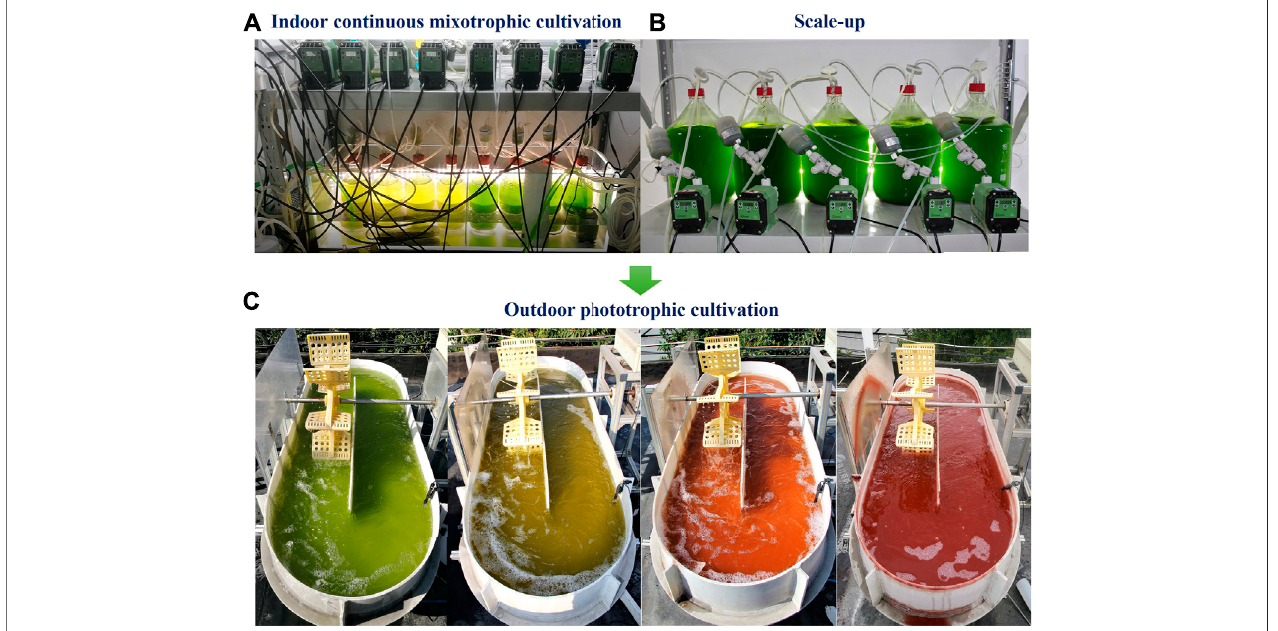
FIGURE 5 | The process of sequential indoor continuous mixotrophic and outdoor phototrophic cultivation. (A) Indoor continuous mixotrophic cultivation of H. lacustris (BBM with 5 mM Ac) in 2 L PBRs carried out at a temperature of 23 ° C under a light intensity of 160 μ mol photons m − 2 s − 1 , 3% (v/v) CO 2 , and pressurized air bubblingata fl owrateof250 ml min − 1 . (B) Scale-upofcontinuousmixotrophiccultivation in10 LPBRstoprepareseedculturesof H.lacustris forORPs(modi fi edBBM with different levels of nitrogen, 5 mM Ac, at a dilution rate of 0.54 days − 1 under a light intensity of 160 μ mol photons m − 2 s − 1 , 3% (v/v) CO 2 , and pressurized air bubbling at a fl ow rate of 250 ml min − 1 ). (C) Outdoor phototrophic cultivation of H. lacustris in ORPs to produce astaxanthin (14-day cultivation